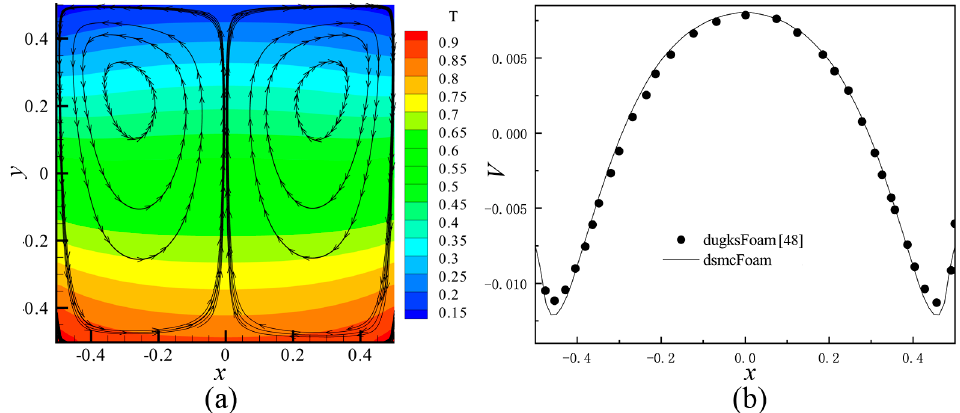
Figure 3. The simulation results of square cavity with dsmcFoam. ( a ) Temperature contours and velocity streamlines at Kn = 0.1 by dsmcFoam. ( b ) Profile of the V component of the velocity on horizontal line, passing through the center of the left primary vortex at Kn = 0.1. In ( b ), black points show the results extracted from [43], and the curve shows the results of dsmcFoam.